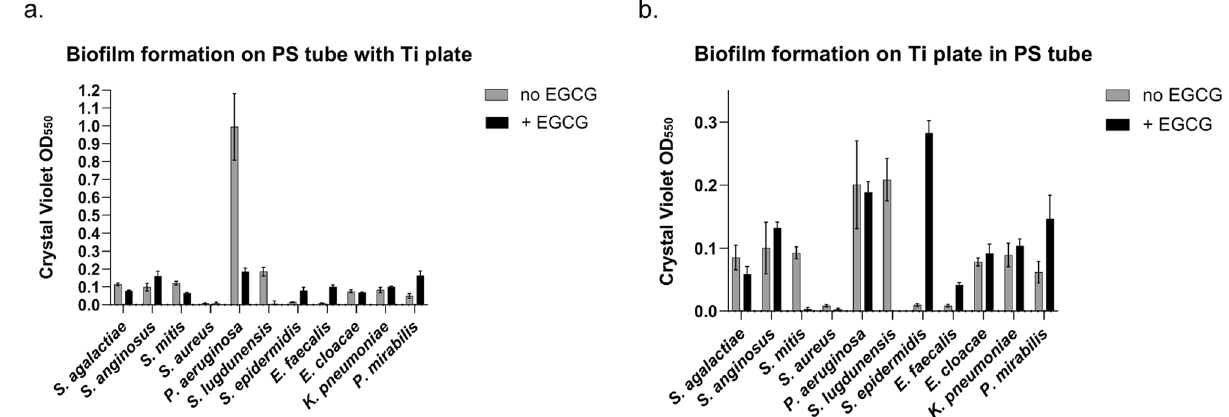
Figure 6. Epigallocatechin gallate (EGCG)-induced changes in biofilm formation on PS and Ti. Each microorganism was cultured to form biofilms on the surface of PS tube or Ti plate in the absence or presence of EGCG. ( a ) Biofilms on the PS tube surface were stained with CV, and their absorbance was measured at 550 nm. ( b ) Biofilms on the Ti plate surface were stained with CV, and their absorbance was measured at 550